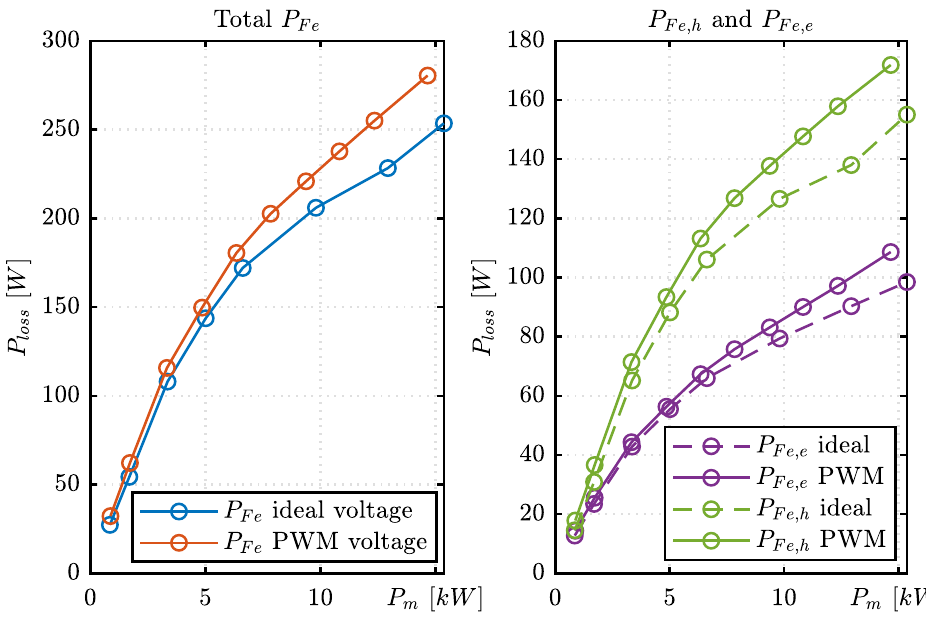
Figure 15. Iron loss at constant speed: total ( left ), hysteresis, and eddy current components ( right